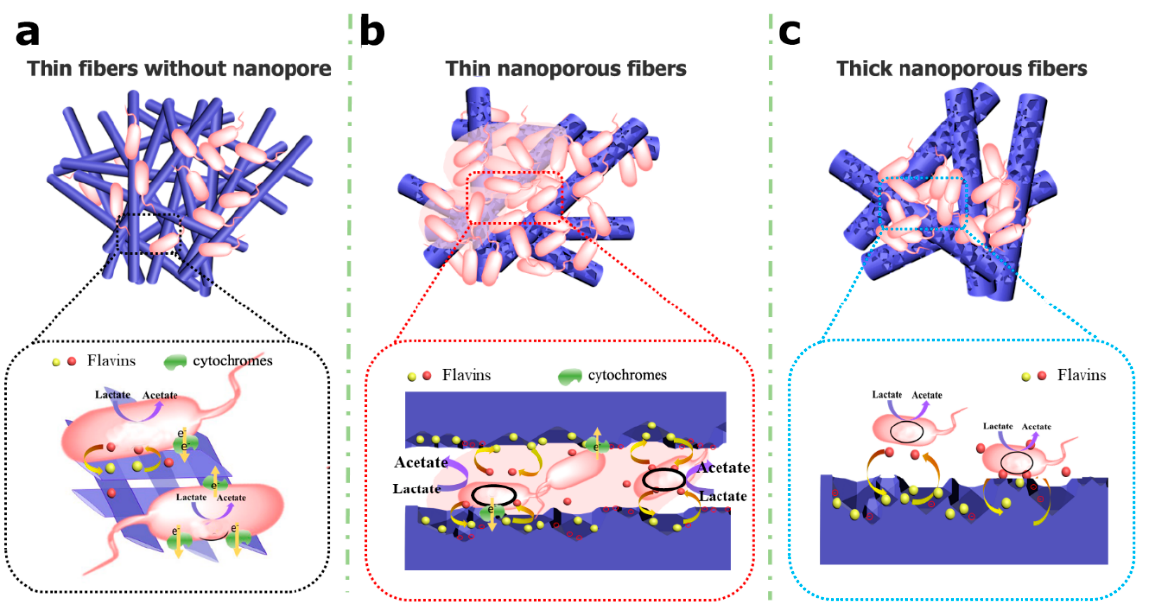
Figure 7. Proposed mechanism for structure-dependent interfacial electron transfer on nanoporous carbon fiber electrodes. ( a ) thin fibers without nanopores; ( b ) thin nanoporous fibers; ( c ) thick nanoporous fibers).